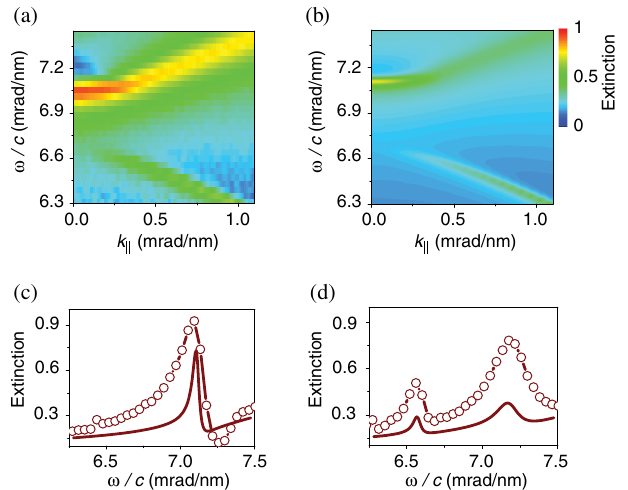
FIG. 2. Measurements (a) and finite-element simulations (b) of the extinction spectra of the array shown in Fig. 1. Panels (c) and (d) are cuts at k k ¼ 0 and k k ¼ 0 : 4 mrad = nm , respectively, of both (a) and (b). The open circles in (c) and (d) are measure- ments and the solid curves are simulations.